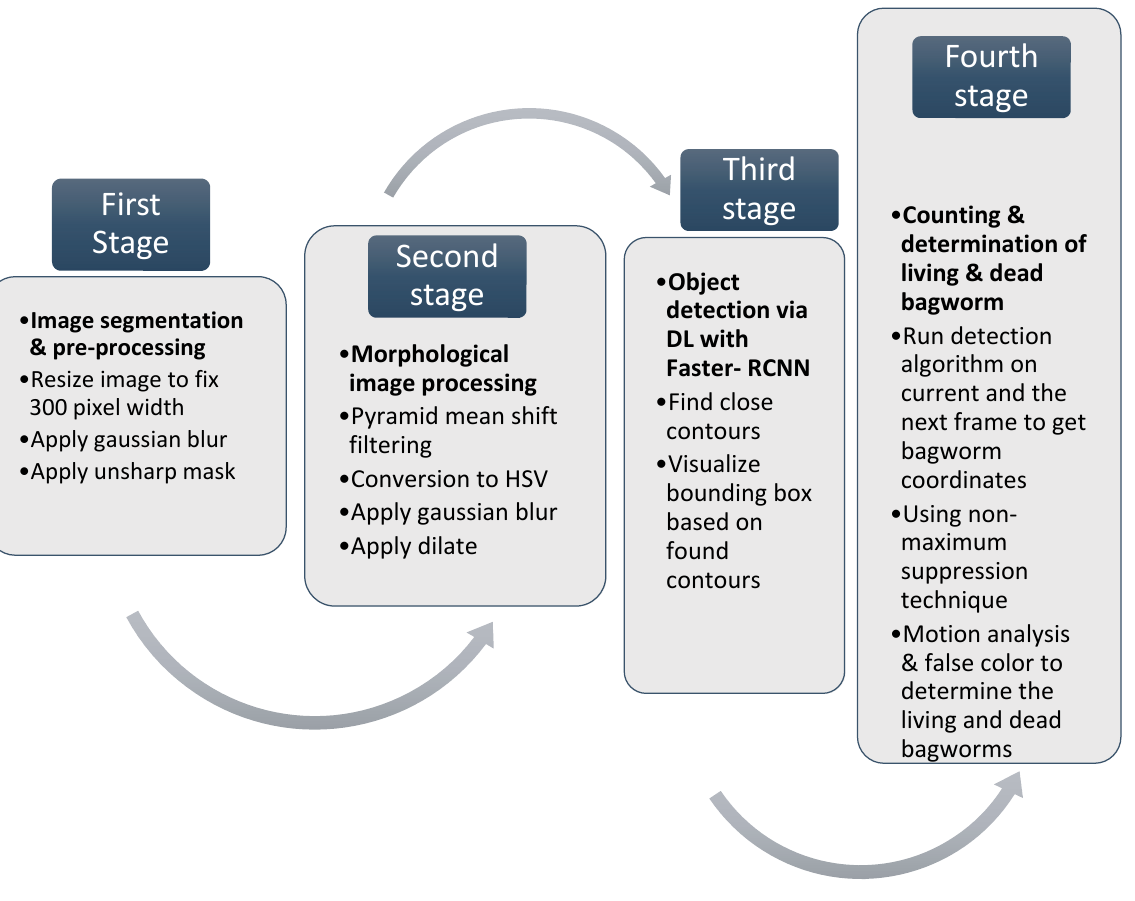
Figure 1. Big picture of the four stage methodology for bagworm detection.